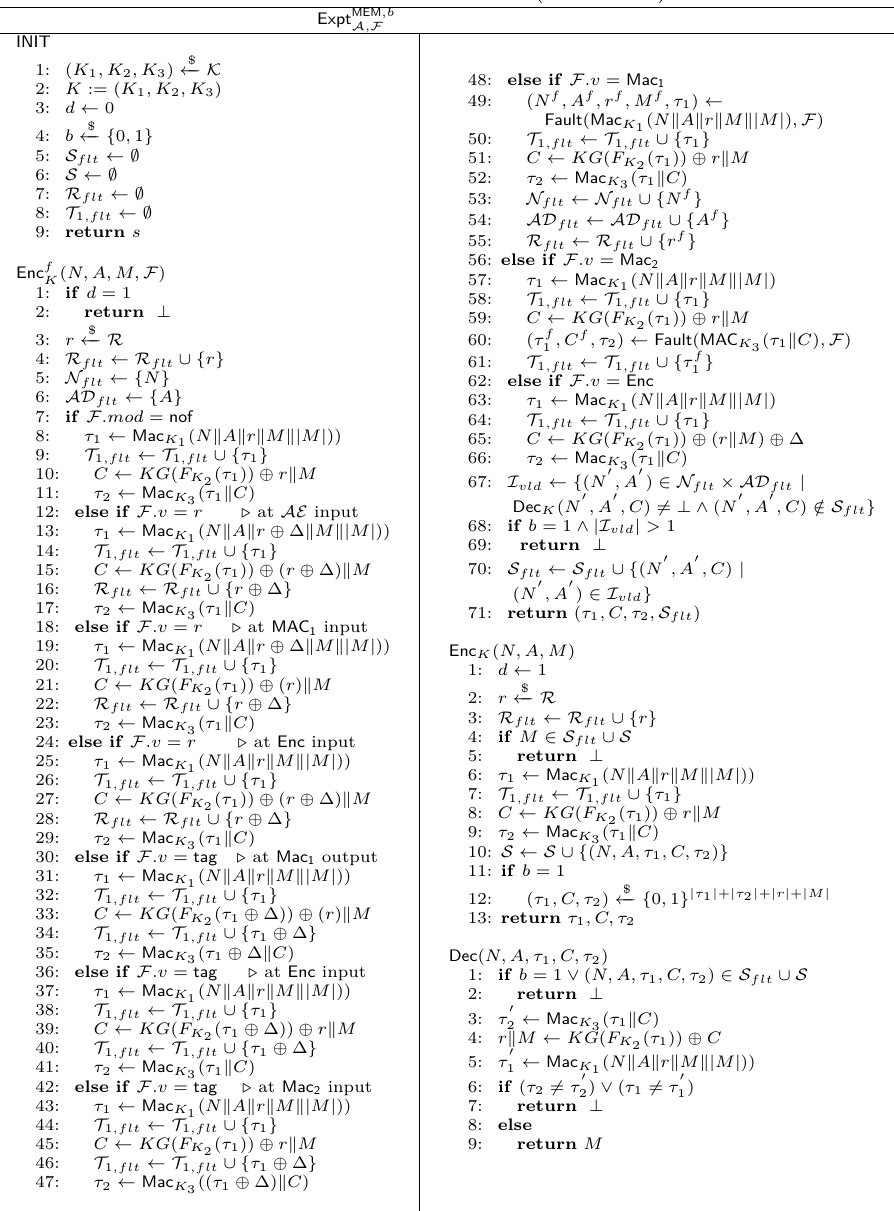
Table 10: The MEM oracles